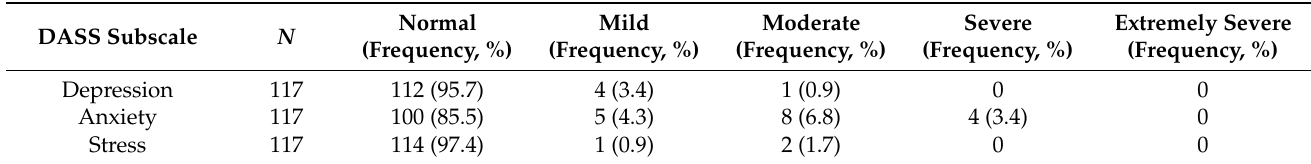
Table 4. The frequency of distress